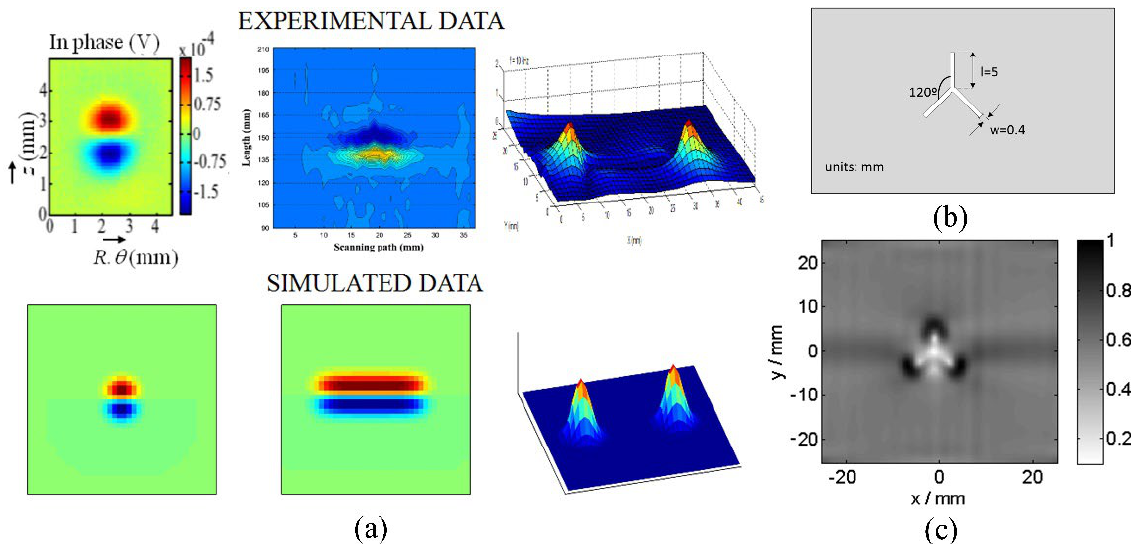
, , and , , and 𝑥𝑥 𝑦𝑦 𝑥𝑥 𝑦𝑦